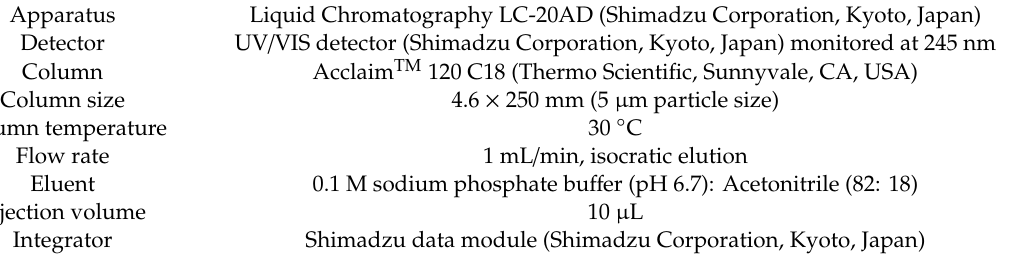
in Table 1. The molecular weight of KRG-P was determined by using high-performance size-exclusion chromatography with the Agilent 1260 Infinity liquid chromatography system (Agilent Technologies, Santa Clara, CA, USA) equipped with an Asahipak GS series (GS-520, GS-320, and GS-220) linked to the column (Showa Denko, Co. Ltd., Tokyo, Japan) and a refractive index detector (Agilent 1200 series). KRG-P was dissolved in distilled water (10 mg / mL, 10 µ L) and analyzed using an isocratic bu ff er (50 mM ammonium formate bu ff er, pH 5.5). Molecular weights were determined from a calibration curve generated by using standard pullulans (P-5, 10, 20, 50, 100, 200, 400, and 800) (Showa Denko Co. Ltd. Minato-ku, Tokyo, Japan). Table 1. HPLC analytical conditions to determine polysaccharide fraction (KRG-P) monosaccharide composition.